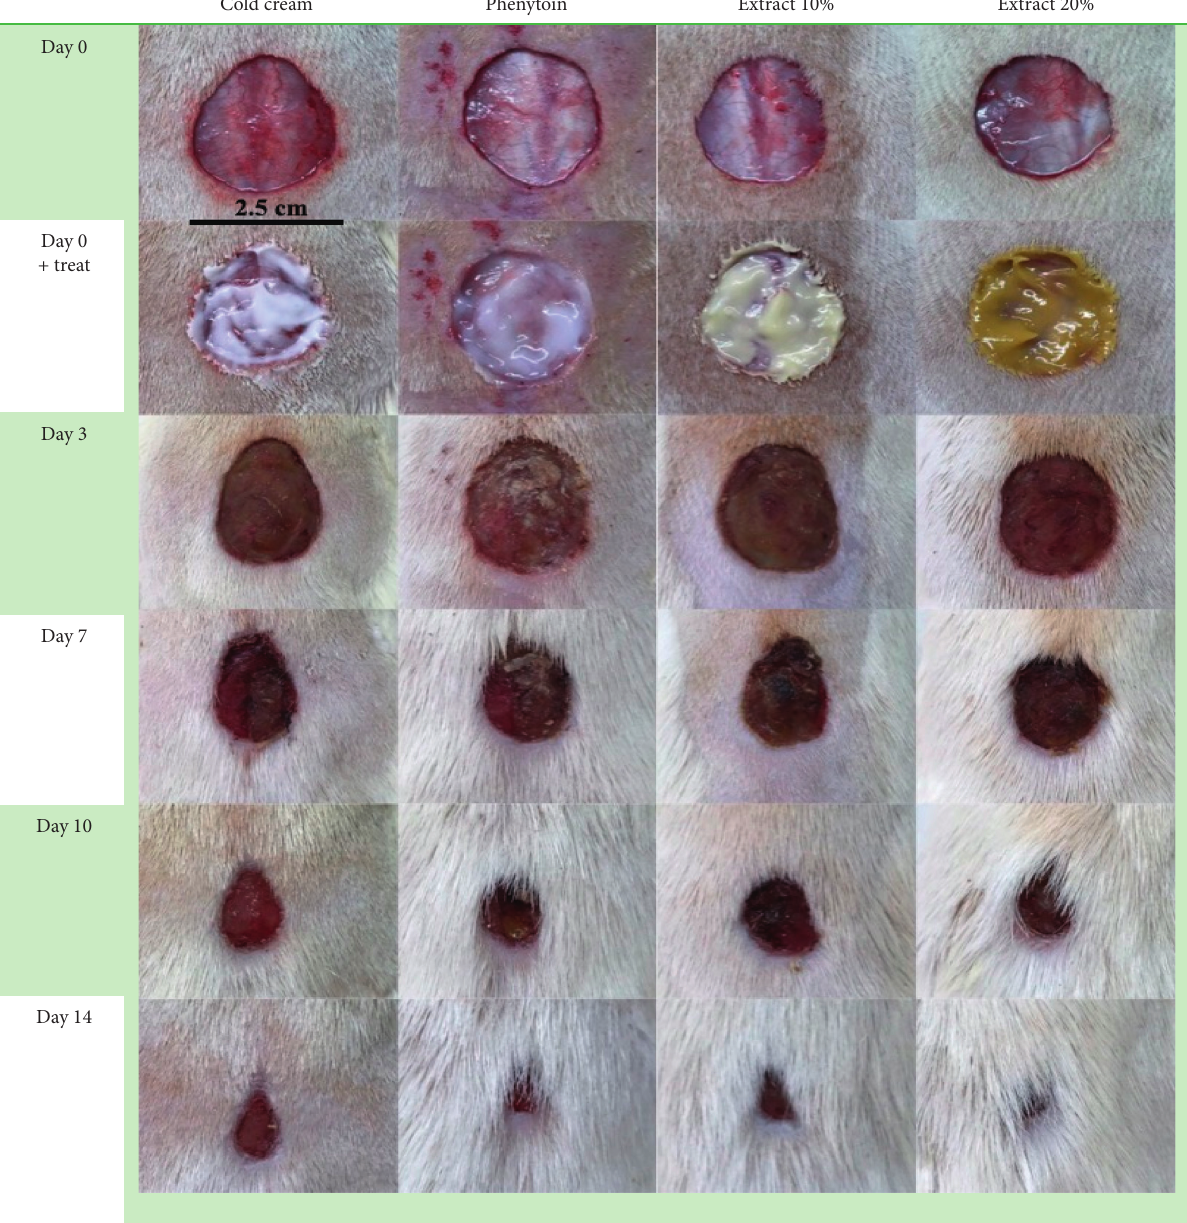
Figure 1: The macroscopic trends of wound healing in control, phenytoin-treated, extract 10%, and extract